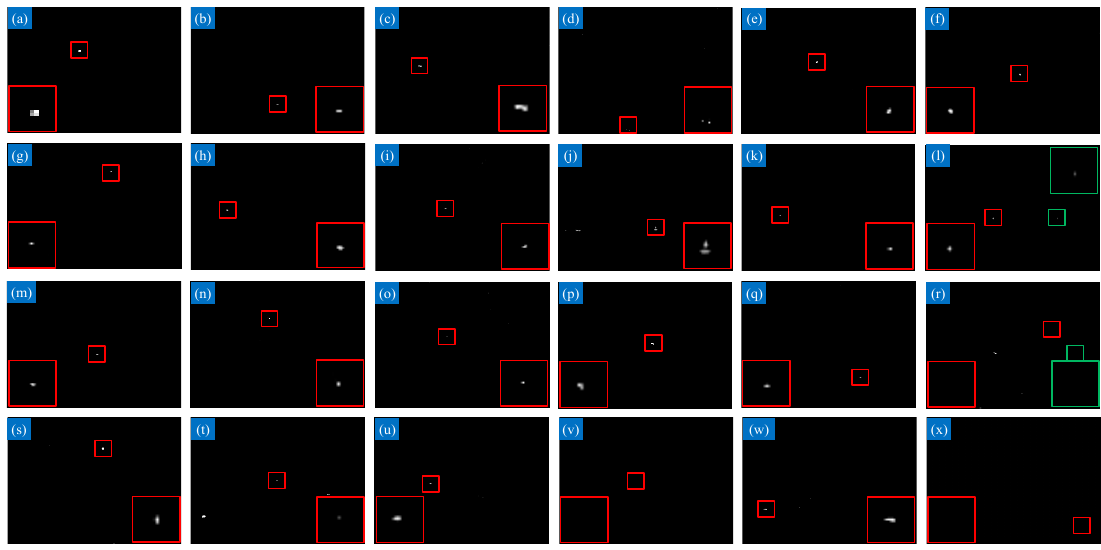
Figure A8. The separated target images of NRAM under 24 scenes.